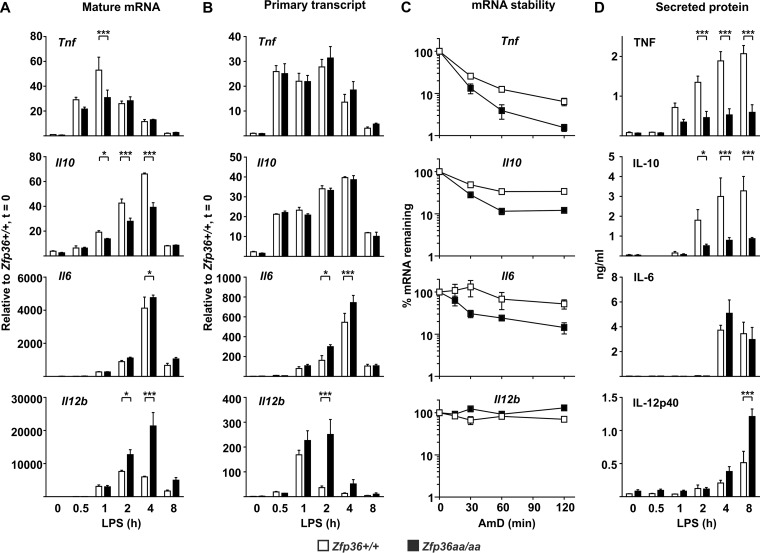
TTP mutation affects gene expression at different levels. Zfp36+/+ and Zfp36aa/aa M-BMMs were treated with LPS for the times indicated, supernatants were collected, and RNA was isolated. (A) Steady-state mRNA abundance was measured by quantitative PCR. (B) Levels of primary transcripts were measured by quantitative PCR. (C) Actinomycin D (AmD) chase experiments were performed at the peak of gene expression (1 h in the case of Tnf and 4 h in the cases of Il10, Il6, and Il12b). (D) Levels of secreted proteins were measured by an ELISA or a multiplex bead assay. Graphs represent means ± standard errors of the means of data from three independent M-BMM cultures in each case. Pairwise comparisons that showed no statistical significance are not indicated. *, P < 0.05; **, P < 0.01; ***, P < 0.005 (by a Mann-Whitney test).